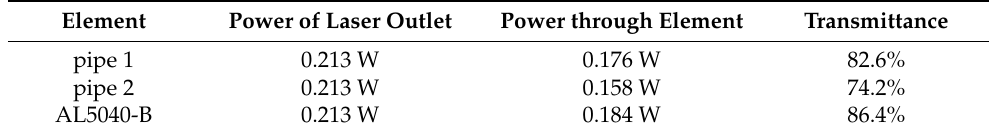
Table 2. Transmittance of the homogenizing pipe and aspheric lens. Element Power of Laser Outlet Power through Element Transmittance pipe 1 0.213 W pipe